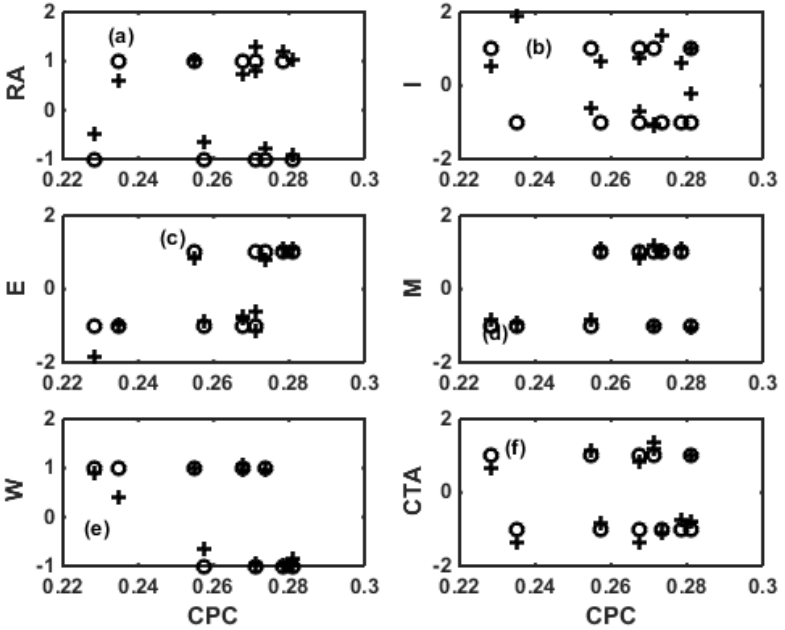
Figure 4. Comparison of the predictions between the unseen targeted values (o) and the values obtained using ANN (+) for desired cumulative copolymer composition levels vs. ( a ) reducing agent, ( b ) initiator, ( c ) emulsifier, ( d ) monomer, ( e ) water, and ( f ) chain transfer agent.